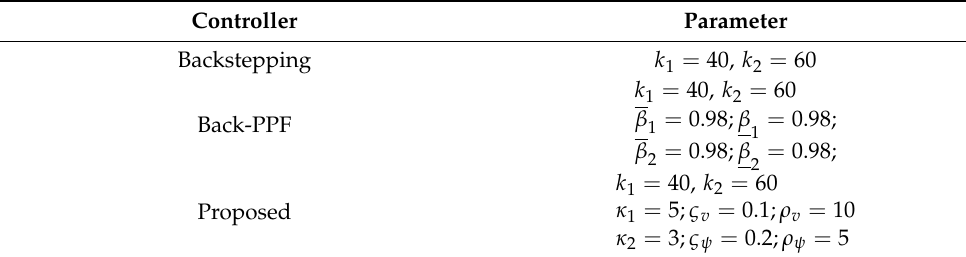
Table 2. Half-car suspension